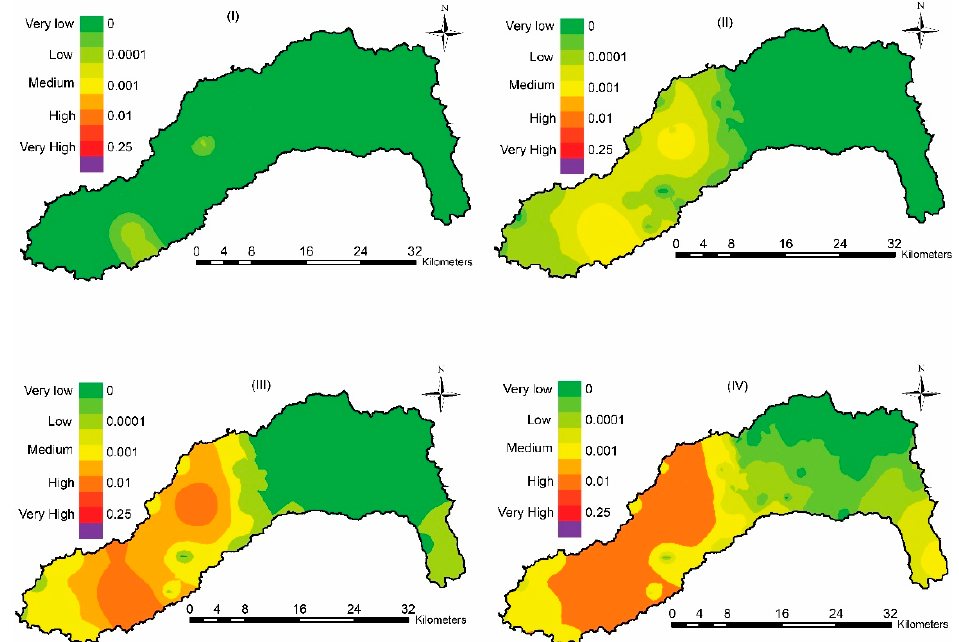
Figure 9. Weighted average leaching potential (all pesticides) in Jazan watershed as assessed by EAF index model under four leaching potential scenarios: low, 0.0003 m d − 1 (I); medium, 0.0005 m d − 1 (II); high, 0.001 m d − 1 (III); and very high recharge rate, 0.002 m d − 1 (IV).